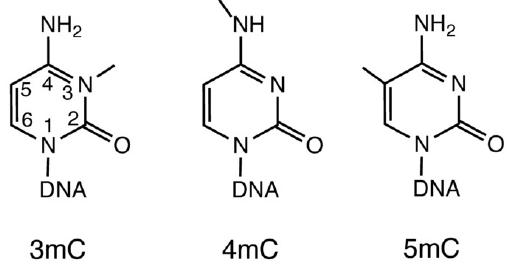
Figure 1. Structure of 3-methylcytosine, 4-methylcytosine and 5-methylcytosine in DNA. 2-oxoglutarate (2OG)-dependent dioxygenases are a type of non-heme iron protein that During the DNA damage, 3-methylcytosines (3mC) are generated. These 3mC bases create methyl lesions which impair local DNA function [6]. In normal cells, these lesions are removed by DNA repair pathways, but they may persist in cancer cells, leading to malignancy. Furthermore, when 3mC is encountered, high fidelity polymerases are inhib- ited, affecting transcription as well [7]. So, the removal of 3mC is crucial for the prevention of cancer. On the other hand, in 5-methylcytosine (5mC), the methyl group is present at the C5 position of the cytosine molecule. In mammalian cells, 5mC in the CpG dinucleotide context plays critical roles in X-chromosome activation, nuclear reprogramming, genomic im- printing and gene expression [8–10]. The dynamic epigenetic modulation of 5mC is also im- portant during different phases of pluripotency, differentiation and development. [11]. In ad- dition, these modified bases are generally found in gene promoter, which inhibits gene ex- pression. So, the removal of 5mC is crucial for gene expression and transcription [12].